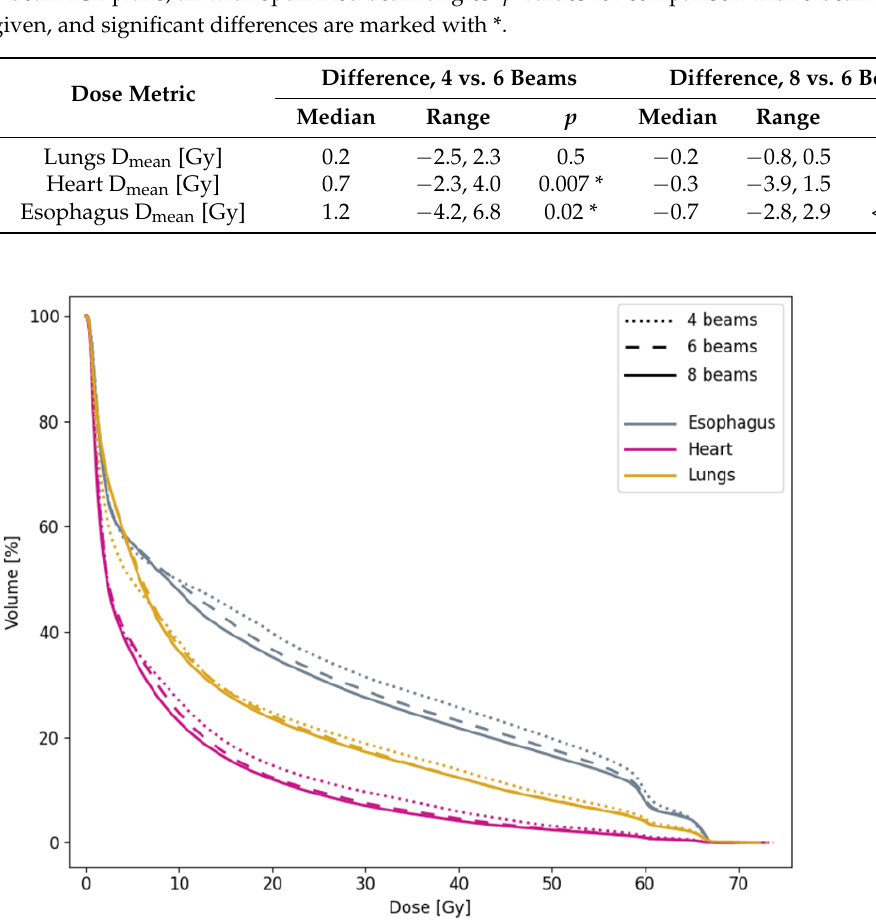
Figure 5. Population average DVHs for OARs in 4-, 6- and 8- beam iCE plans with optimized beam angles.